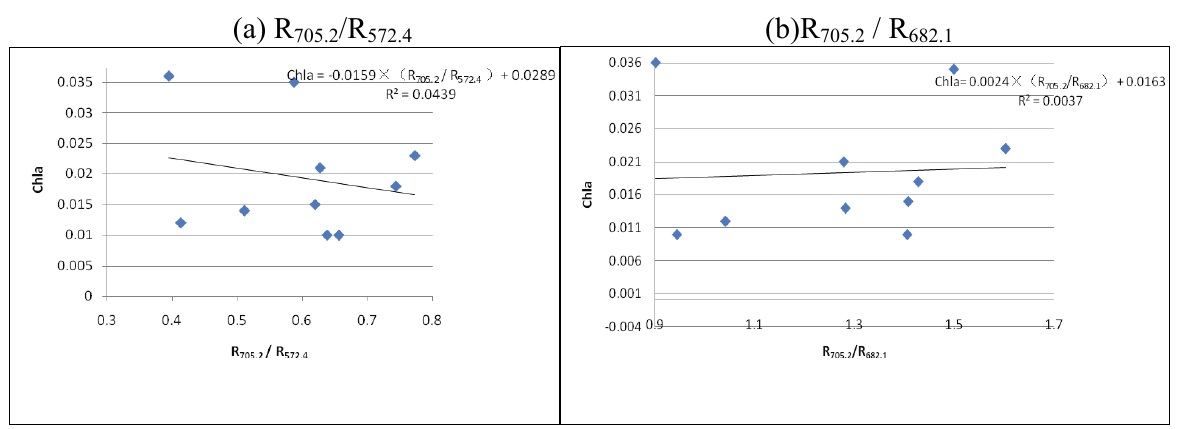
Figure 6. Linear models with reflectance ratios of characteristic bands.